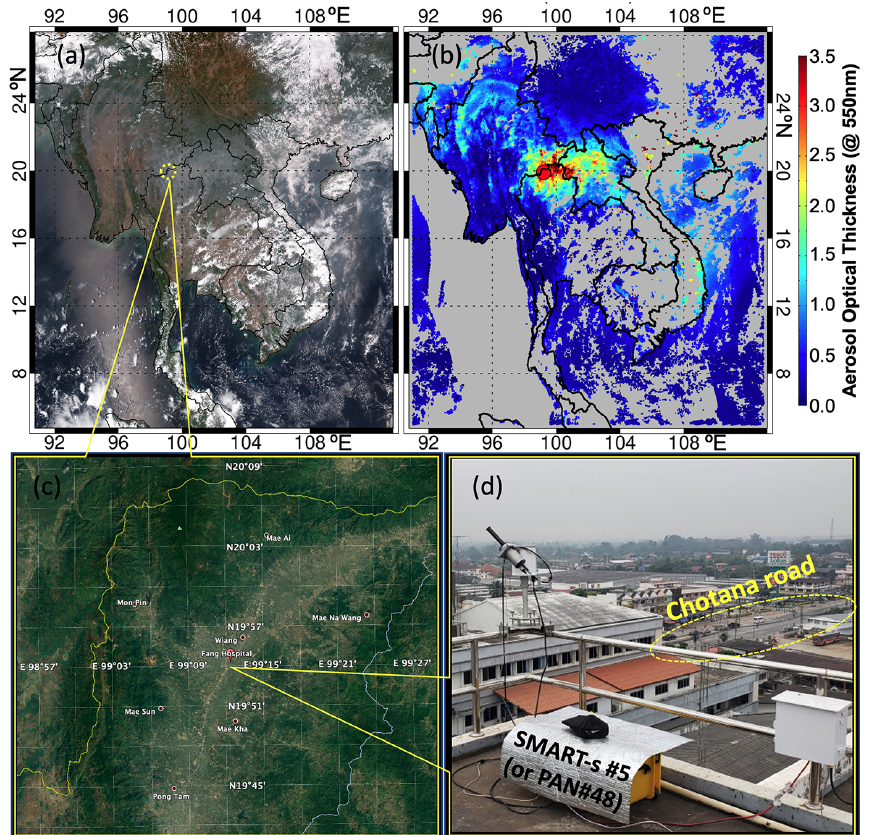
Figure 1. (a) True-color image and (b) DB (Deep Blue) τ aer product from VIIRS aboard SNPP on 30 March 2019. The yellow circle in panel (a) is the location of Fang, Thailand, and the colored circle in panel (b) shows the collocated τ aer retrievals from SMART–s. Panel (c) indicates the location of the measurement site on the rooftop of Fang Hospital, Thailand (19.91 ◦ N latitude, 99.21 ◦ E longitude, and 480m above sea level; the map is extracted from https://google.com/maps/, last access: 12 September 2022; © Google Maps 2021). Panel (d) is an image of deployed SMART–s (Pandora no. 48) taken on 8 March 2019. Chotana Road (marked in yellow) is one of the major streets in this area and is about 50m away from the